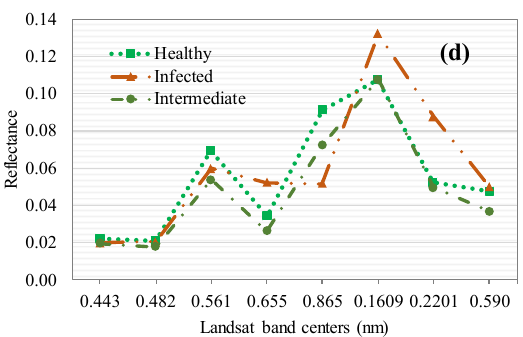
Figure 3: Differences in mean reflectance of healthy, Infected and intermediately infected maize crops based on (a) HyspIRI, (b) Sentinel-2 MSI, (3) VENμS and (d) Landsat OLI spectral settings. In discriminating the different stages of GSL infection